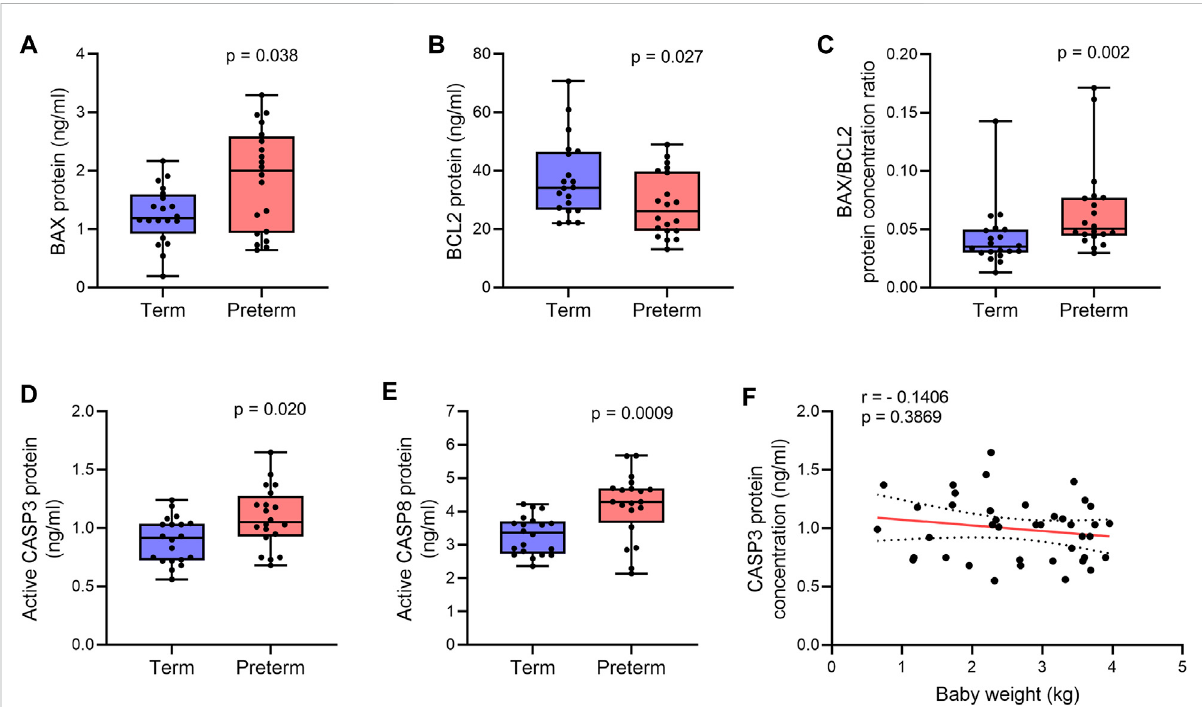
FIGURE 2 Quanti fi cation of apoptotic proteins. (A,B) Box plots of ELISA assays for BAX (A) and BCL2 (B) showing protein concentrations in term and pretermvillousplacentatissuelysates. (C) BoxplotshowingratiobetweenBAXandBCL2proteinconcentrationsintermandpretermplacentas. (D,E) BoxplotsofELISAassaysshowingactiveCASP3 (D) andCASP8 (E) concentrationsintermandpretermplacentas.Totalproteinloadwasat300 μ g/ml for eachsample.n= 20term and20 preterm (A – E) . Data arepresentedas median andIQRwith minima andmaxima.Mann-Whitney U test.